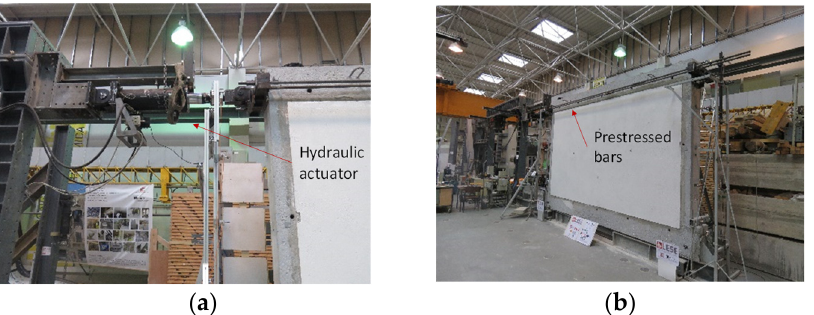
Figure 3. Test setup of the in-plane experimental tests: ( a ) detail of the hydraulic actuator; and ( b ) lateral view.